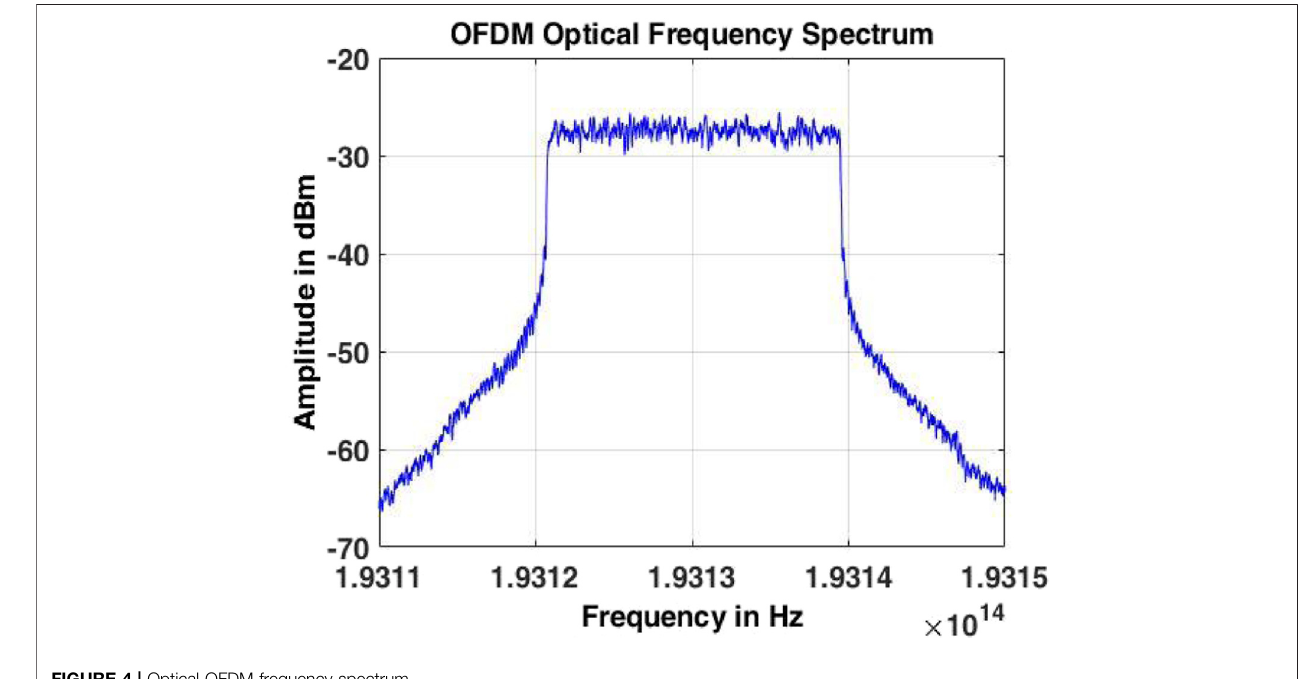
FIGURE 4 | Optical OFDM frequency spectrum.